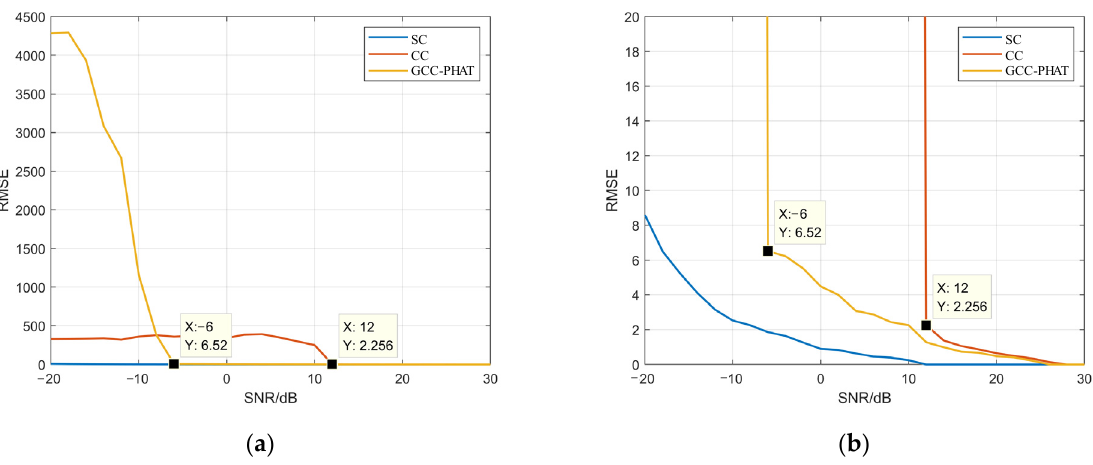
Figure 5. The accuracy of the calculation result of different SNR with three methods. Figure 6. The precision of the three methods when the SNR is -20~30. ( a ) the RMSE of the TDE with different SNR; ( b ) the enlarged view of ( a ) with RMSE of 0–20.